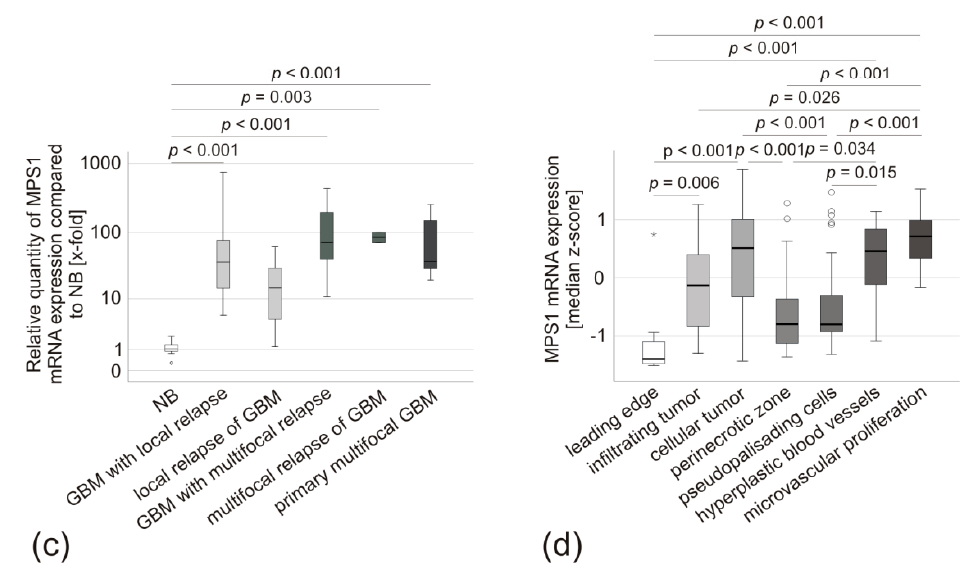
Figure 1. MPS1 mRNA expression in glioma specimens. ( a ) Box-plot comparing MPS1 mRNA expression in NB ( n = 7), PA ( n = 4, median expression 12-fold), IDHmut glioma ( n = 25, median expression 73-fold), IDHwt glioma ( n = 11, median expression 96-fold), and GBM ( n = 57, median expression 91-fold). The median is displayed by the middle line. The quartiles are represented by the hinges, extreme values, up to 1.5 times the height of the box, are shown by whiskers and outliners represented by points. NB was set as the reference. Groups were compared by ANOVA with Levene’s test to assess the equality of variances and Sche ff e procedure or Dunnet-T3 as post hoc tests. p -values are based on di ff erences of ∆∆ Cq-values. ( b ) Scatter diagram of tumor aggressiveness and MPS1 mRNA expression, linear regression, p -values were calculated by ANOVA based on ∆∆ Cq-values. The global e ff ect size was determined by Cohen’s f . ( c ) Boxplot of MPS1 mRNA expression in GBM with local relapse (n = 14, median expression 112-fold), local relapse of GBM ( n = 5, median expression 21-fold, p = 0.06), GBM with multifocal relapse ( n = 8, median expression 130-fold), multifocal relapse of GBM ( n = 2, median expression 84-fold), and primary multifocal GBM ( n = 7, median expression 94-fold) compared to NB ( n = 7). The analysis was performed as described in (a). ( d ) IVY-GAP database [26] analysis of MPS1 mRNA expression in di ff erent areas of GBM: leading edge ( n = 16), infiltrating tumor ( n = 24), cellular tumor ( n = 110), perinecrotic zone ( n = 25), pseudopalisading cells around necrosis ( n = 40), hyperplastic blood vessels in cellular tumor ( n = 22), and microvascular proliferation ( n =